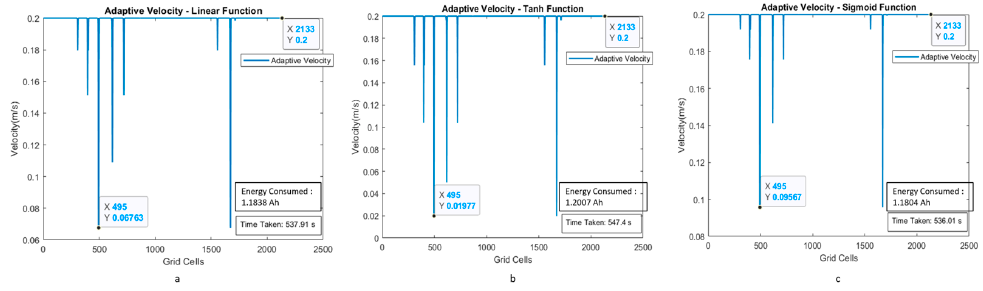
Figure 12. Adaptive velocity behavior model with linear, tanh, and sigmoid functions with velocity corresponding to the grid cells of the map for scenario I.